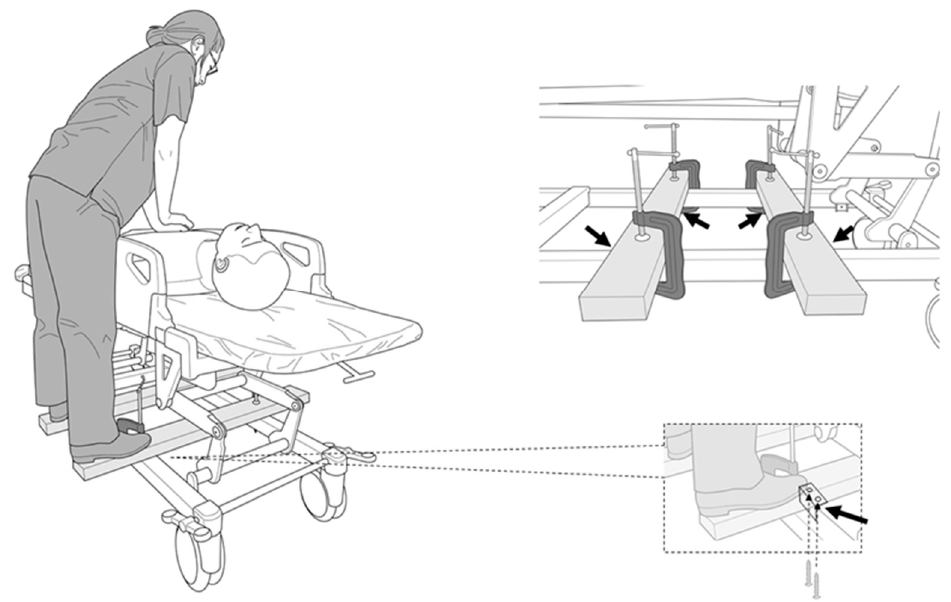
Figure 1. Chest compressions performed with wings attached to the stretcher (the wing method). The picture surrounded by the dotted line shows the L-shaped brackets screwed to the wings. The black arrows indicate the placement of the L-shaped brackets.